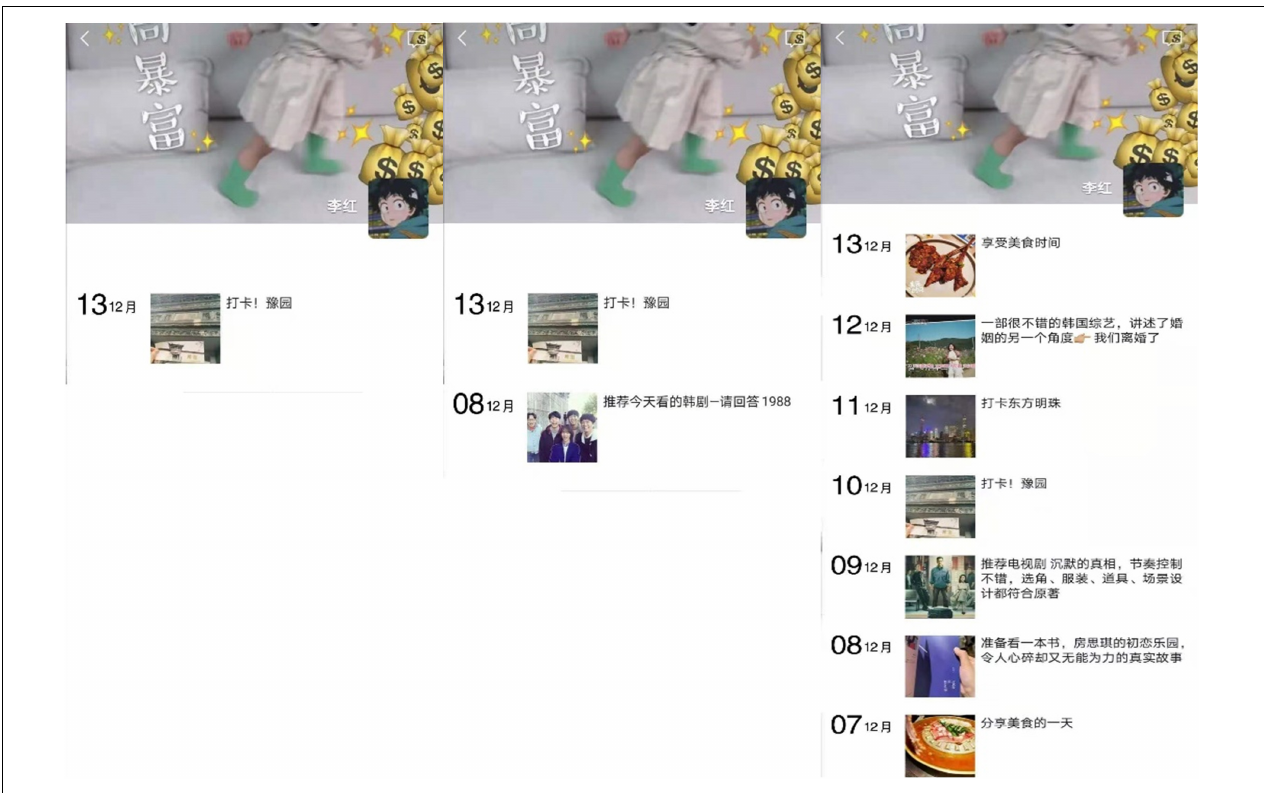
FIGURE 1 | Pictures with different WeChat Moment posting